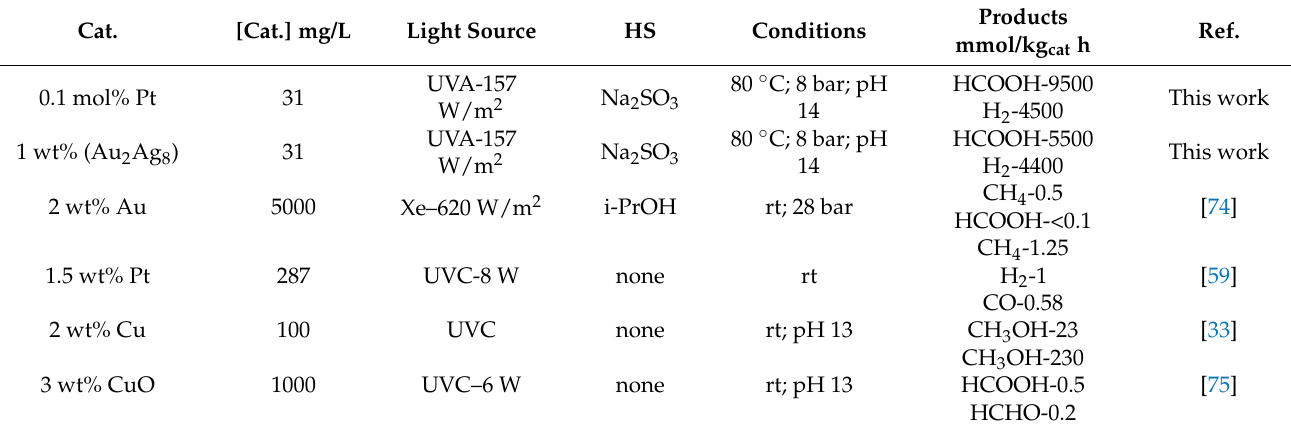
Table 5. Performance in the CO 2 photo-reduction of different photo-catalysts reported in literature.